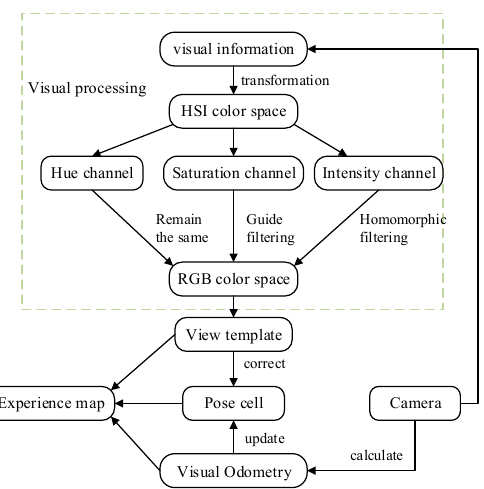
Figure 3. Framework of bionic navigation algorithm based on HSI color space.